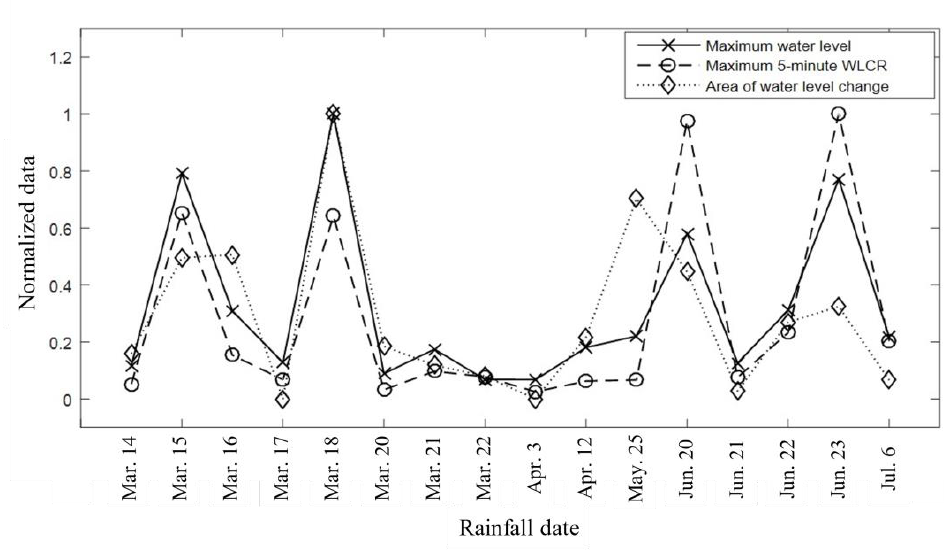
Figure 19. Normalized maximum water level, WLCR, and area data with the 16 rainfall events are presented. The results indicate a similar tendency by the rainfall events.